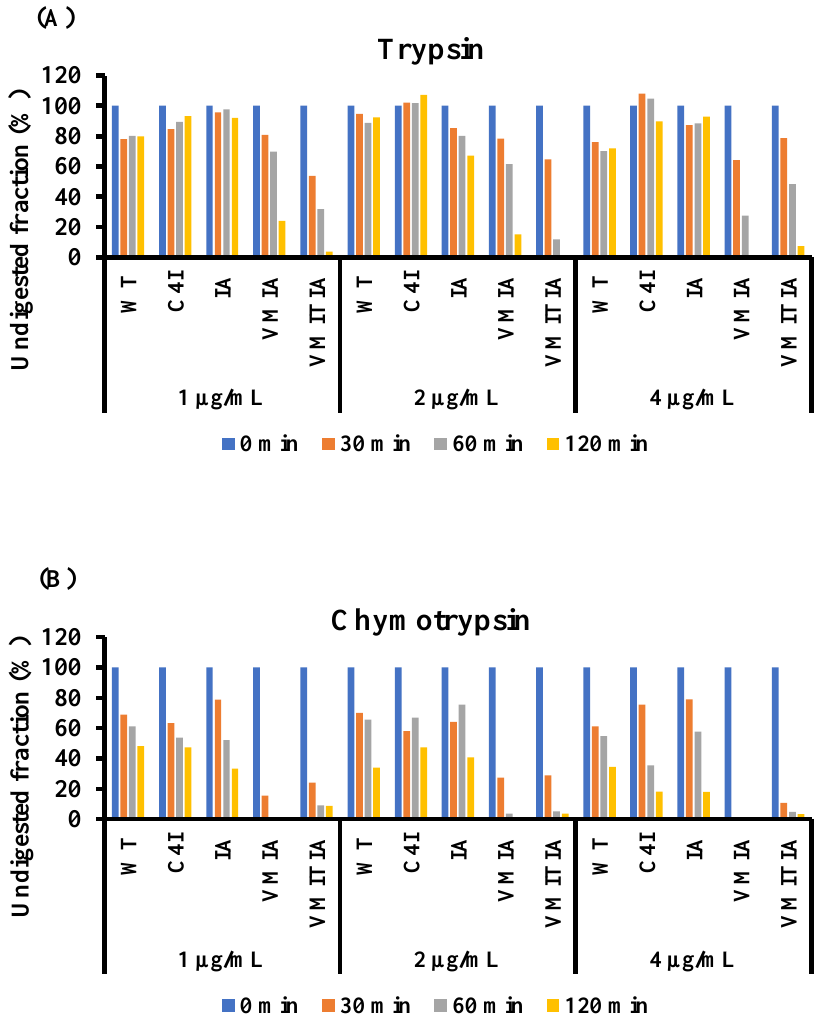
Figure 6. Resistance of the DENV3-ED3 variants to proteolysis. ( A , B ) Undigested fractions of the DENV3-ED3 variants subjected to proteolytic digestion by ( A ) trypsin and ( B ) chymotrypsin at 37 ◦ C. The average intensity of each band was analyzed using MetaMorph (Universal Imaging) image-processing software. The value of the undigested fraction at t = 0 min was normalized to 100% for each